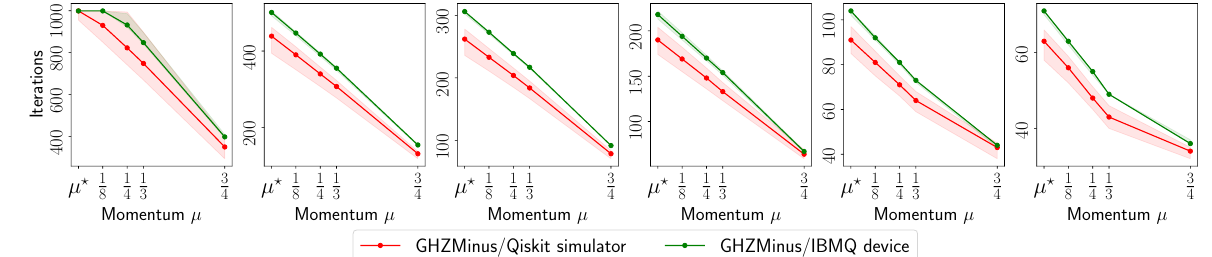
( 8 ) circuit using using real measure- −